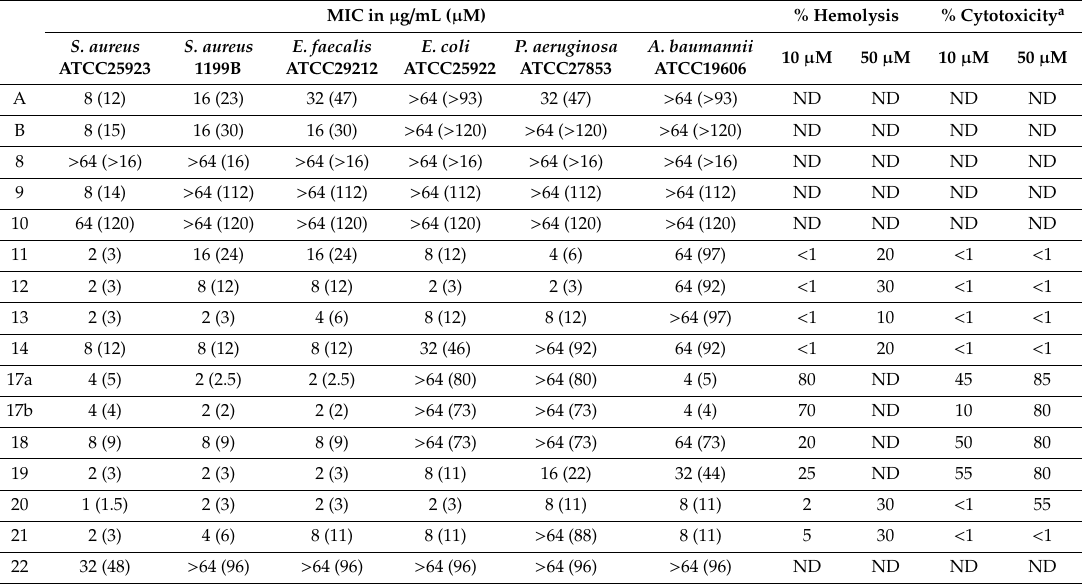
Table 1. Biological activity, hemolytic activities, and cytotoxicity.